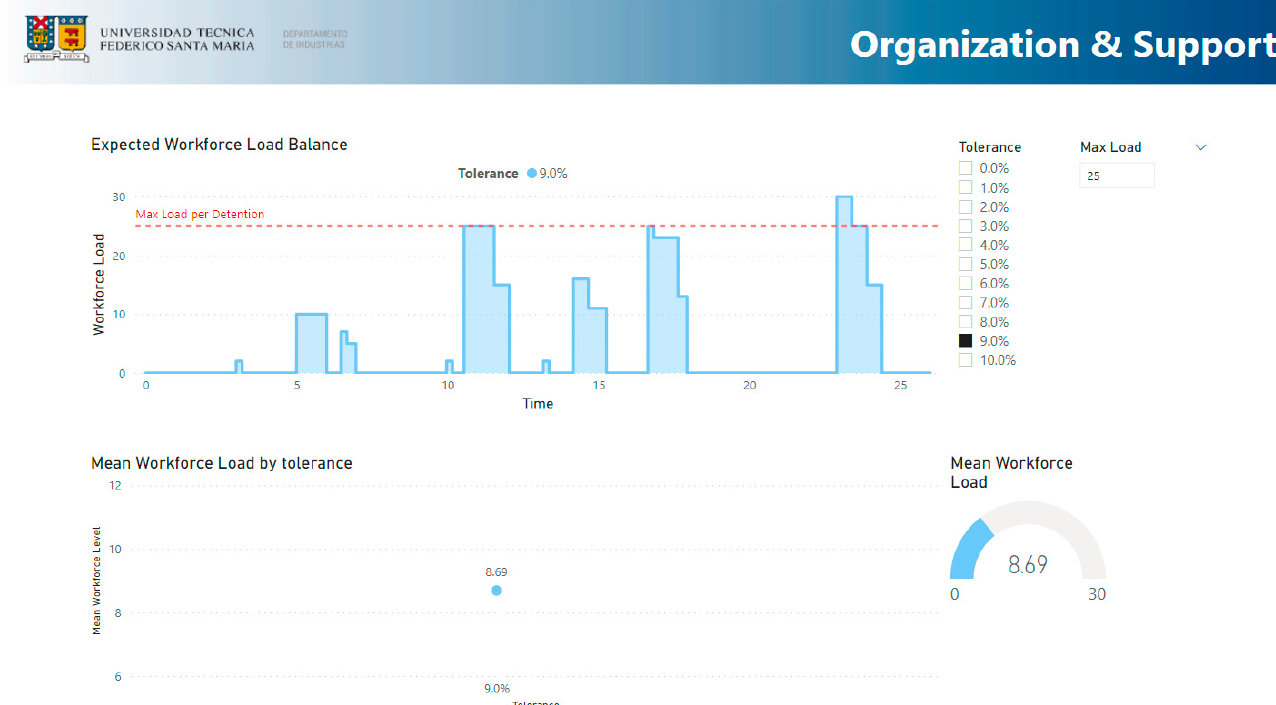
Figure 8. Organisation and support section.